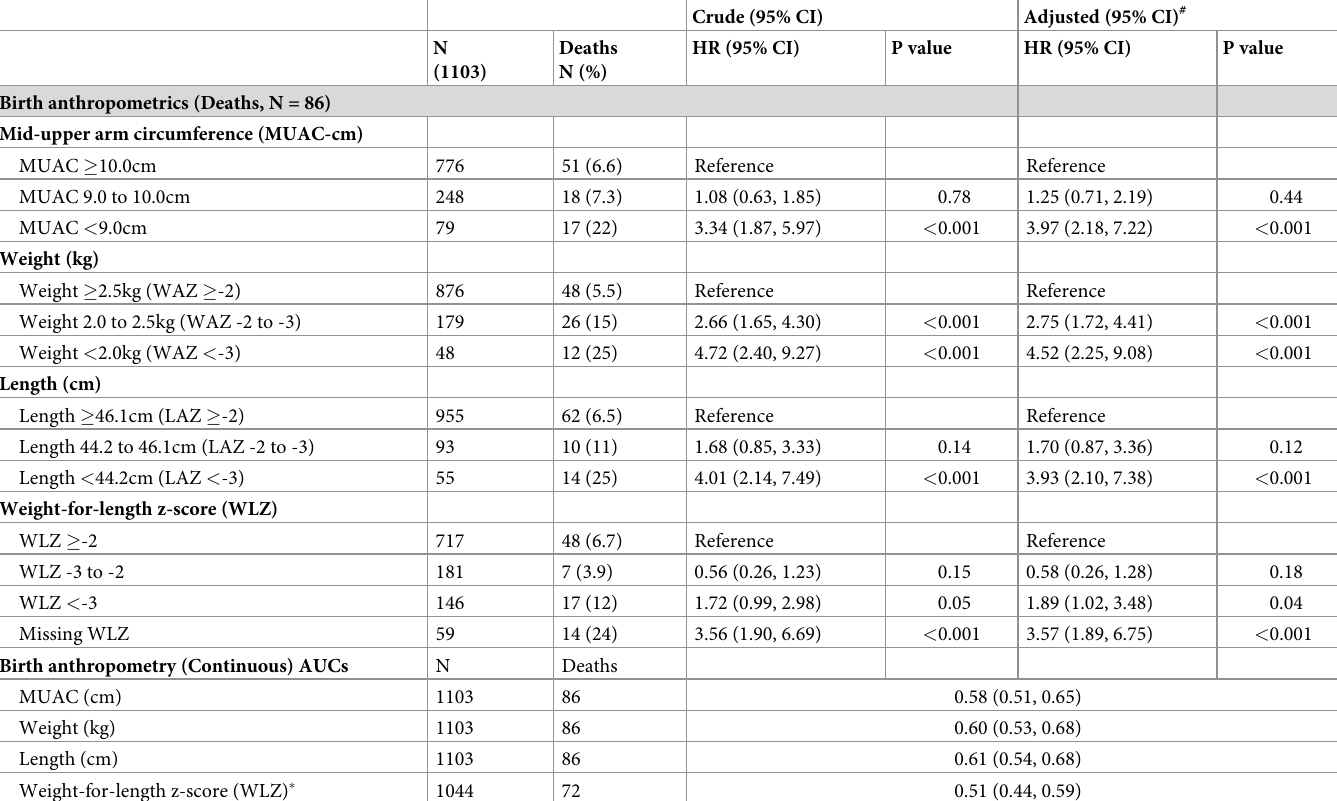
Table 2. Birth anthropometry and mortality to 12 months of